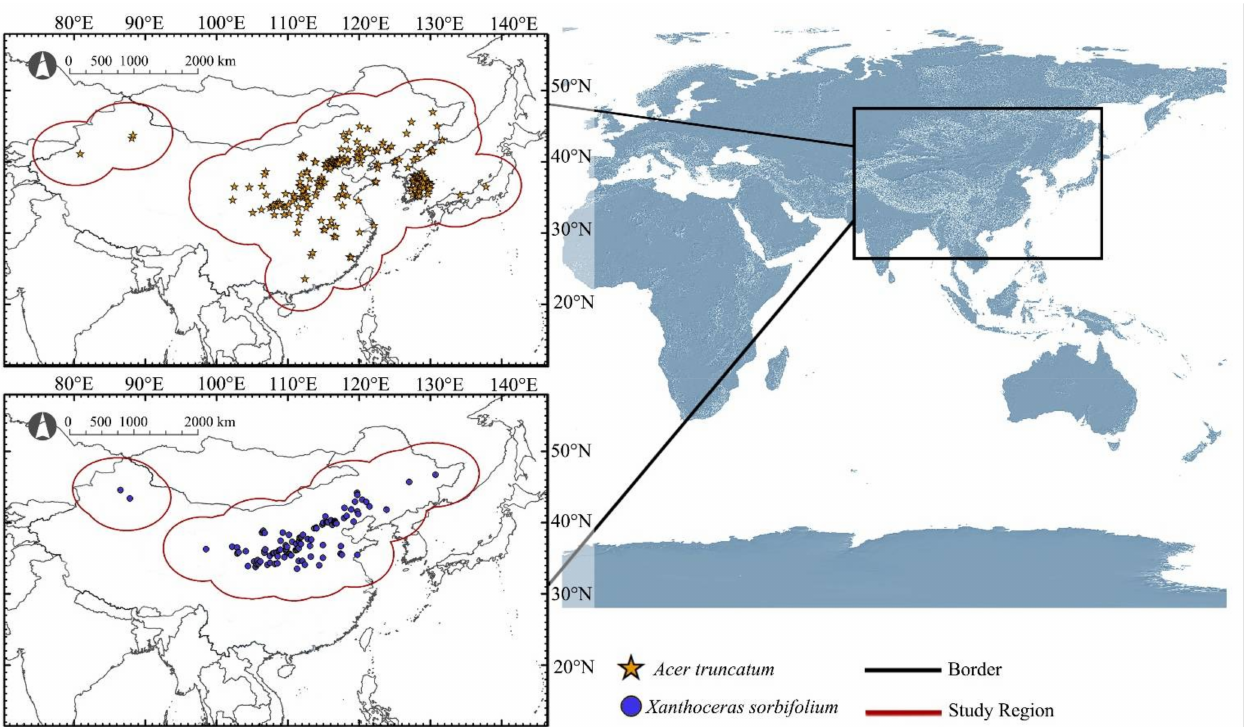
Figure 1. Distribution records and study regions of A. truncatum and X. sorbifolium